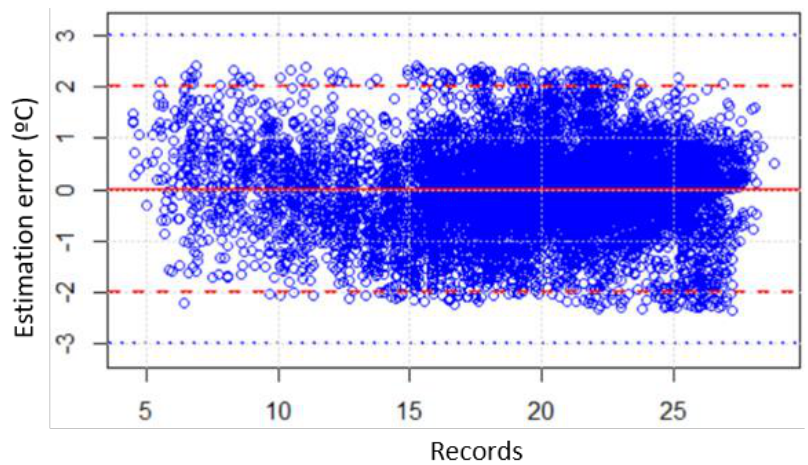
Figure 5. Residual values from the linear model with interactions.